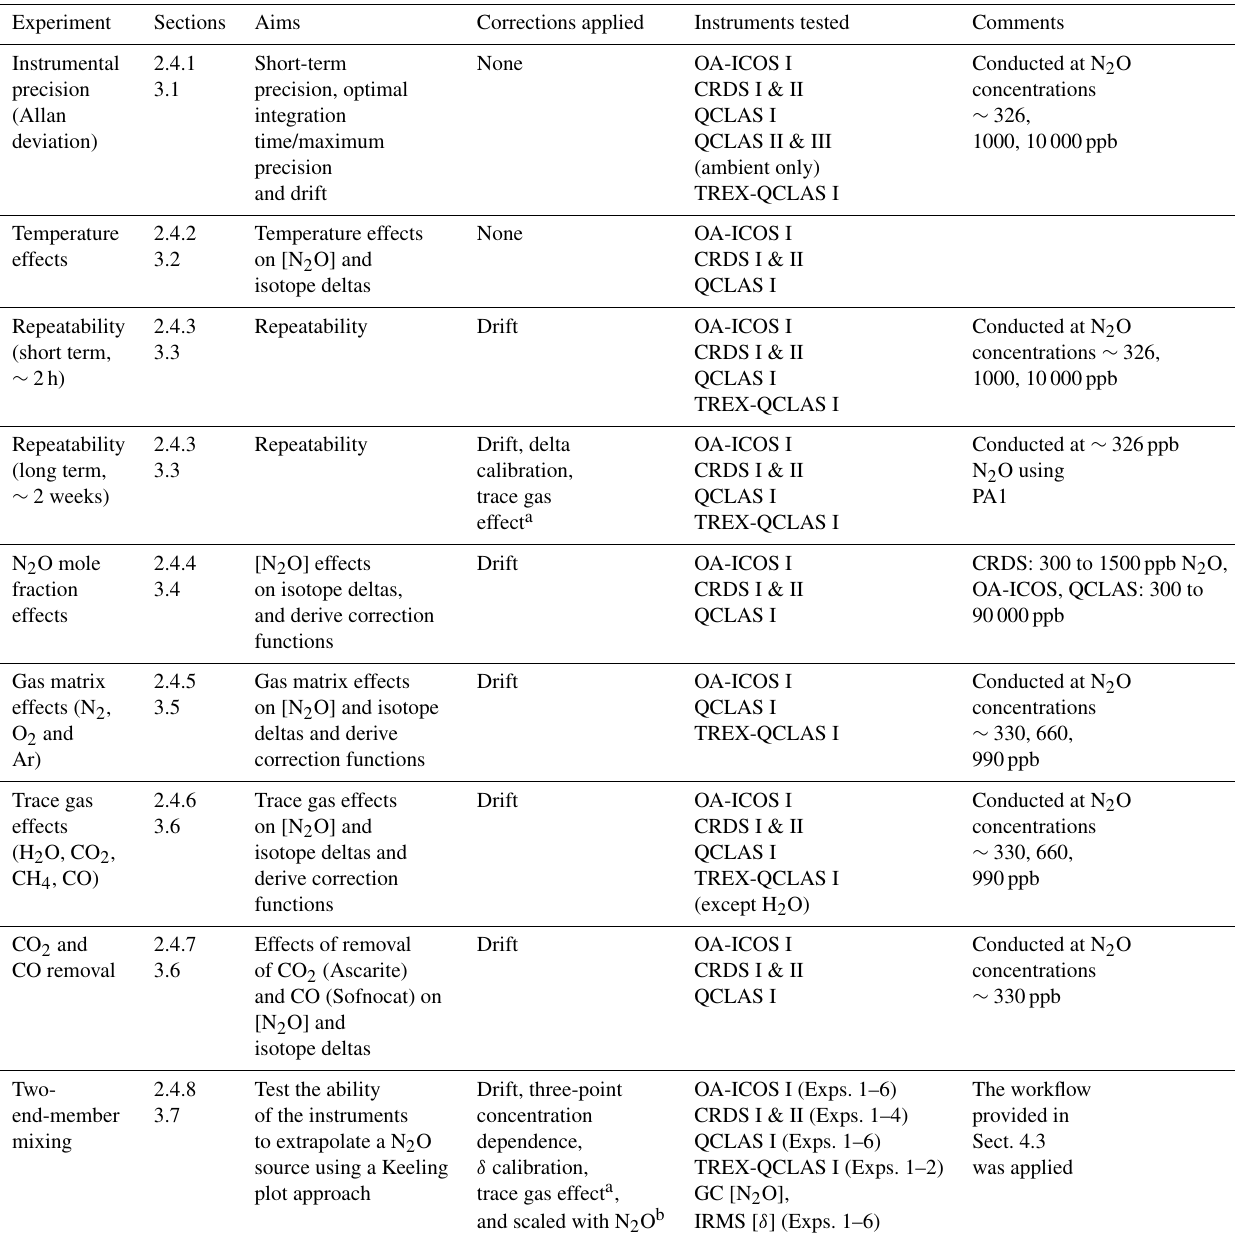
Table 4. Overview of the experiments performed in this study.